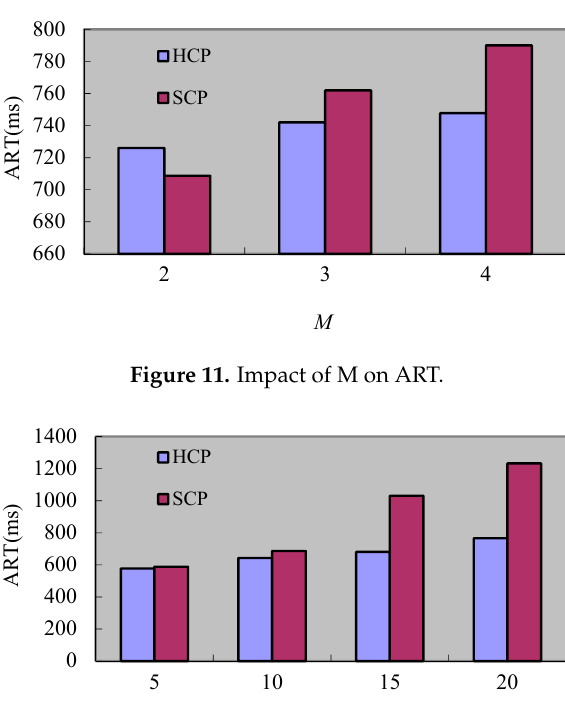
Figure 10. Impact of R on ACT.